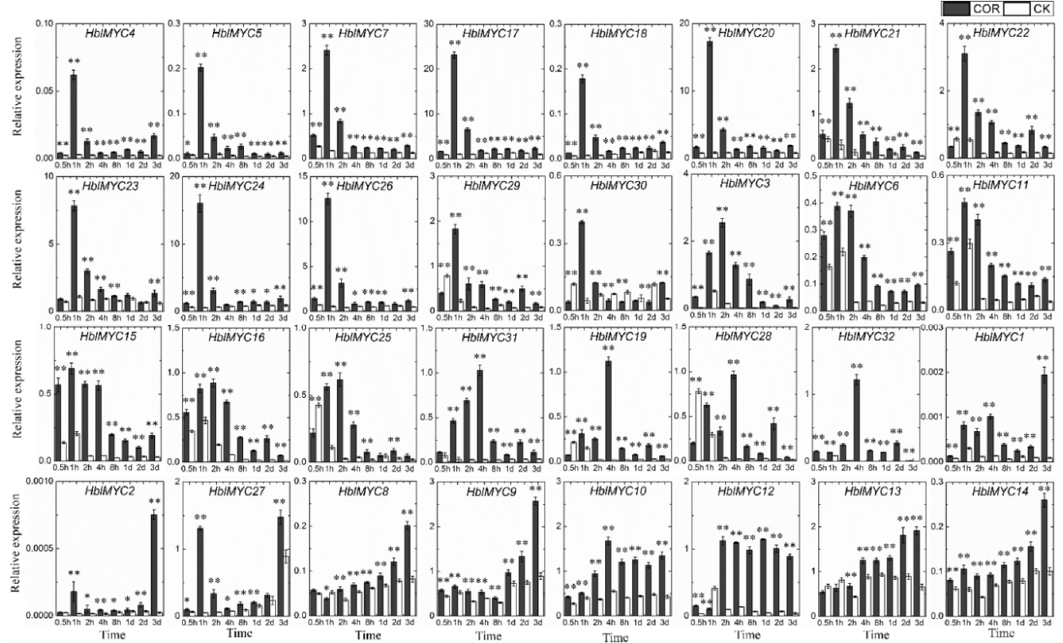
Figure 5. Effect of COR on the expression of HblMYCs in cambial region of Hevea shoots. Values were means ± SD of three replicates. The asterisks (*) and (**) respectively represented significant difference ( p < 0.05) and very significant difference ( p < 0.01).